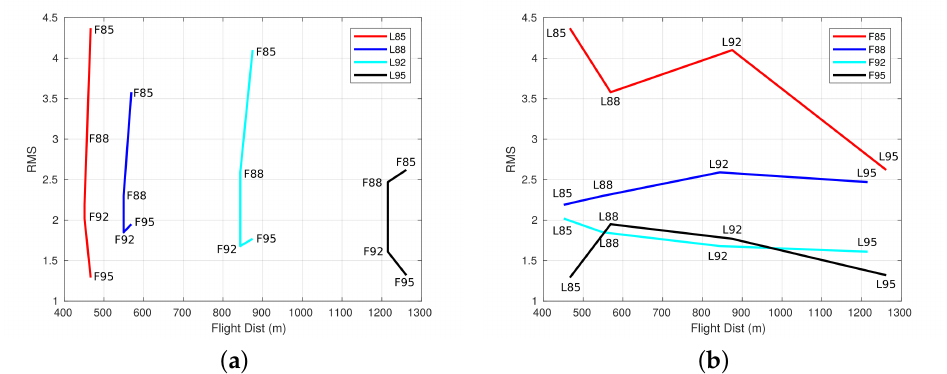
Figure 8. Flight distance versus the RMSE 12 error, for different values of frontal and lateral overlap. ( a ) Lateral overlap variation. ( b ) Frontal overlap variation.